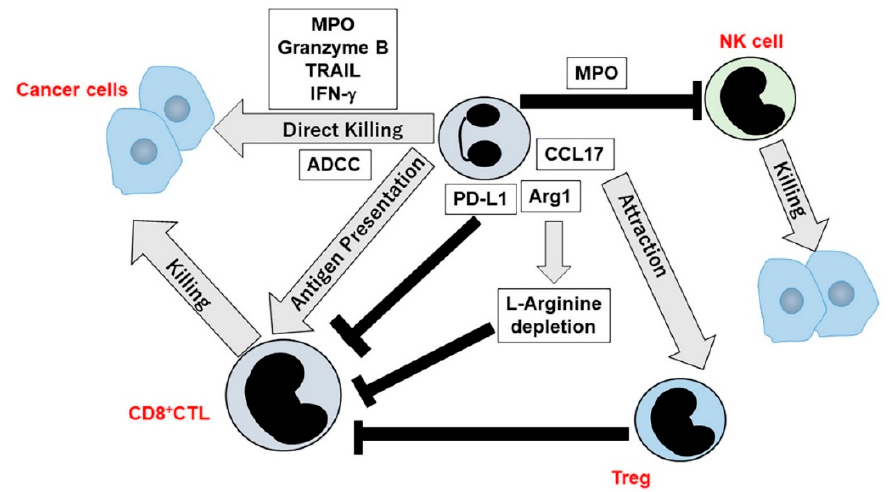
Figure 3. E ff ects of TANs on tumor Figure 3. Effects of TANs on tumor immunity.